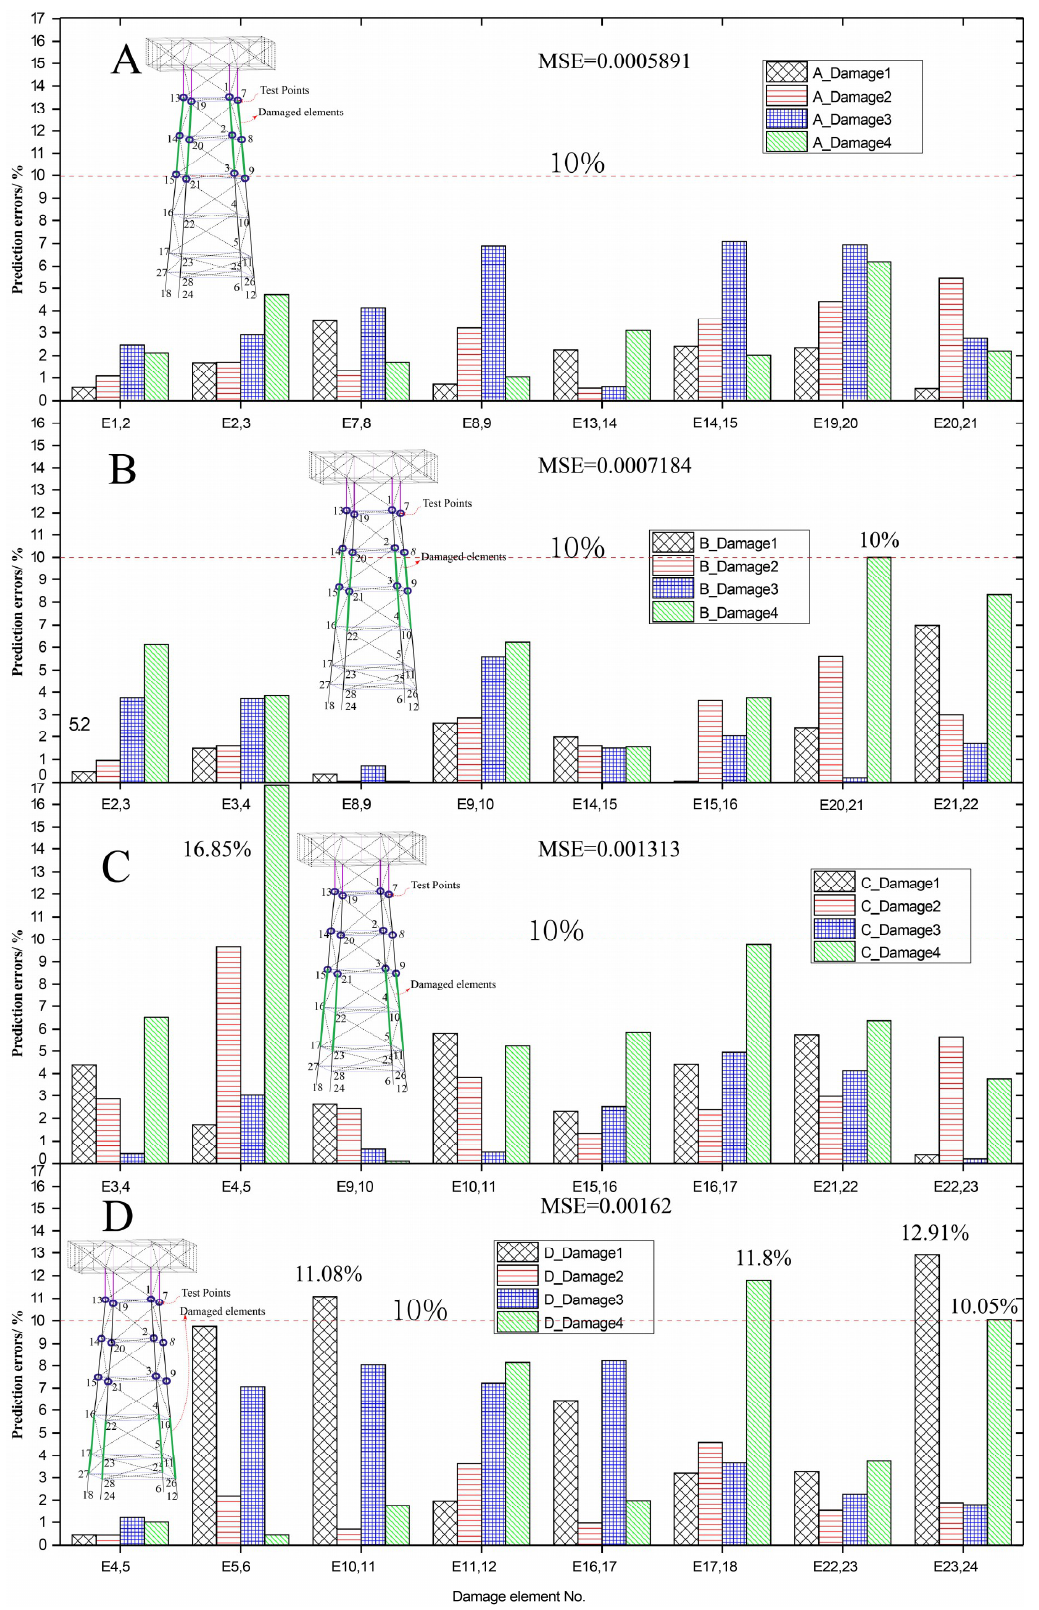
Figure 6. Relative errors of the predicted damage for varying damaged elements.